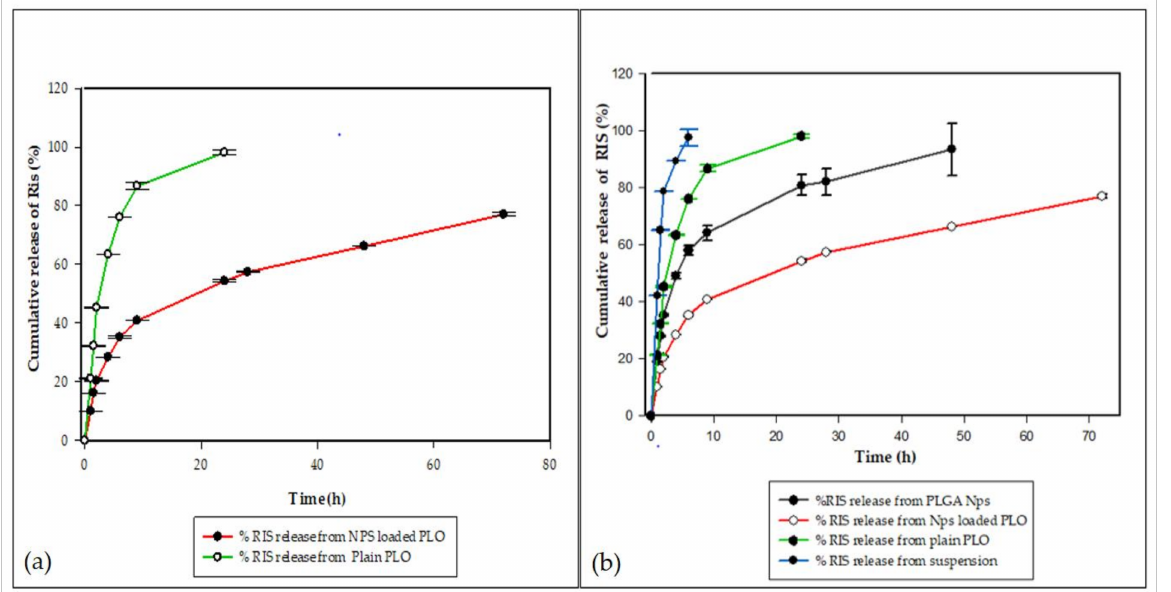
Figure 7. In vitro drug release comparative profiles for ( a ) RIS from NP-loaded PLO and plain PLO in PBS (pH = 7.4, 0.25% tween 80) and ( b ) RIS from simple PLGA NPs, NP-loaded PLO, plain PLO and simple suspension with mean ± S.D. Error bars shows standard deviation ( n = 3).